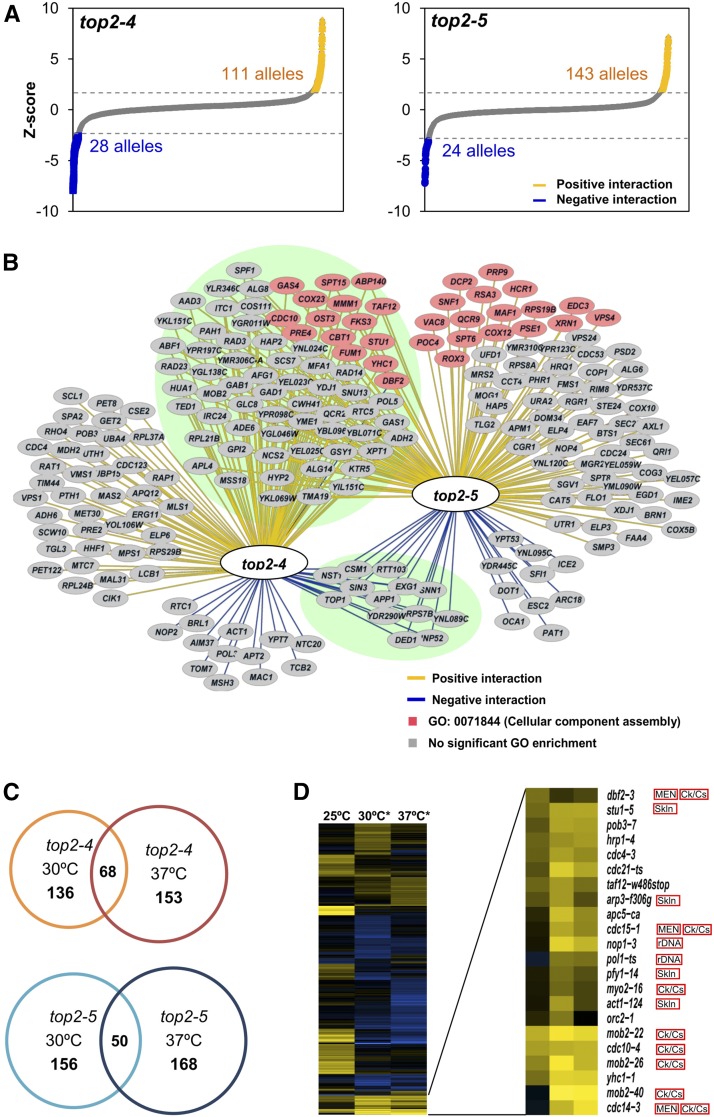
SGA analyses identify the MEN as deleterious enhancers of Top2 downregulation. (A) The z-scores of the genetic interactions detected at permissive temperature (steady growth at 25°) are plotted. The top2-ts arrays of mutants were compared with the TOP2 arrays as a control. 5553 alleles were screened in total. Positive and negative genetic interactions that meet the cutoffs (>2 or < −2) are indicated. (B) Network of the genes that interact with top2-4 and top2-5. Green background encircles the 84 shared genes between the two top2-ts. Pink nodes indicate the positive interaction between top2-5 and genes involved in the aggregation and bonding of cellular components (GO: 0071844). (C) The numbers of genetic interactions identified during steady growth at 30° and after 6 hr incubation at 37° are shown. Circle intersections depict number of genetic interactions shared between both treatments. (D) Heat map of top2-5 SGA scores (those with P < 0.05). Yellow, positive interactions; blue, negative interactions; black, no interaction. The 25° Column represents the z-score obtained comparing top2-5 vs. TOP2 at 25°, whereas the 30° and 37° × 6 hr columns compare top2-5 at these temperature regimes vs. top2-5 at 25°. MEN, mitotic exit network; Ck/Cs, cytokinesis/cell separation; Skln, cytoskeleton; rDNA, ribosomal DNA metabolism.